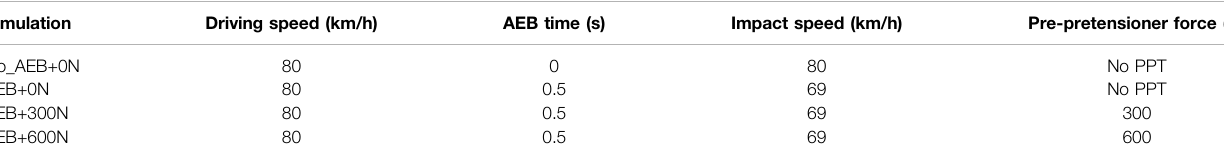
TABLE 1 | Simulation